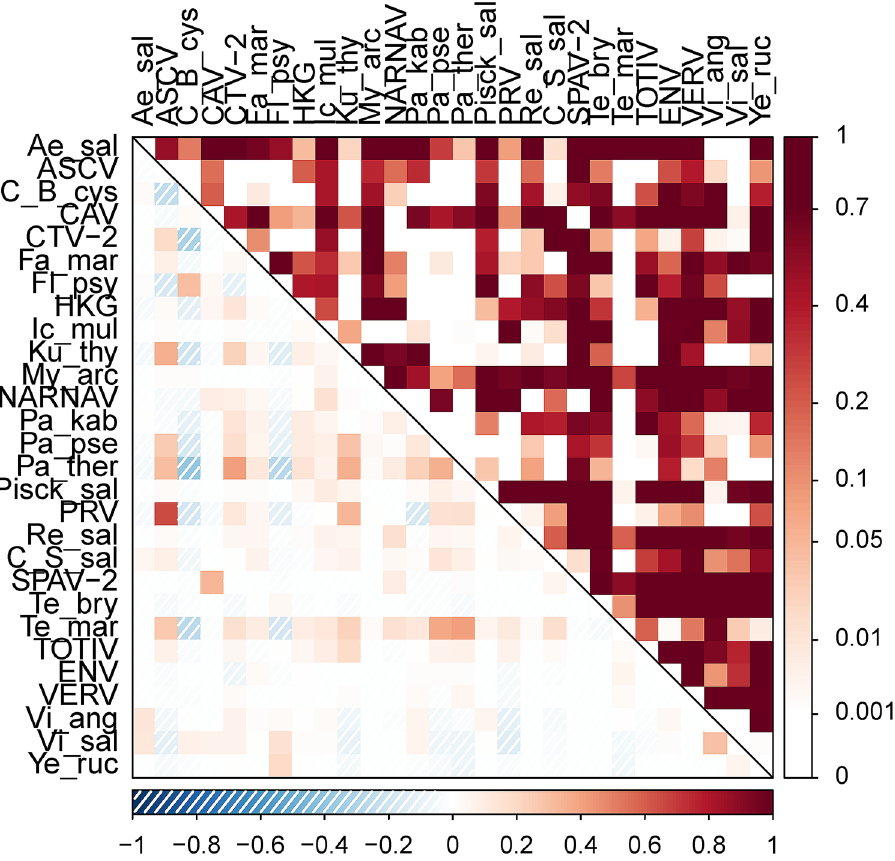
Figure 5. Spearman rank correlations between infectious-agent intensities in farmed Atlantic salmon in BC, Canada throughout four production cycles. See supplementary information for agent abbreviations. Lower left of plot and lower legend indicate correlation values. Upper right of plot and right legend indicate statistical significance of the